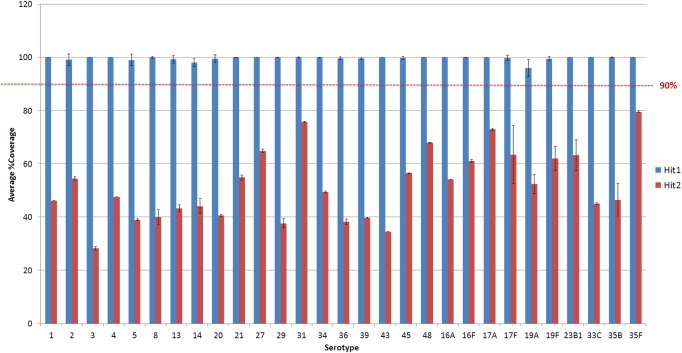
Average % coverage of the top and second hit during stage 1 of the PneumoCaT for serotypes determined by mapping coverage only.Error bars correspond to standard deviation.